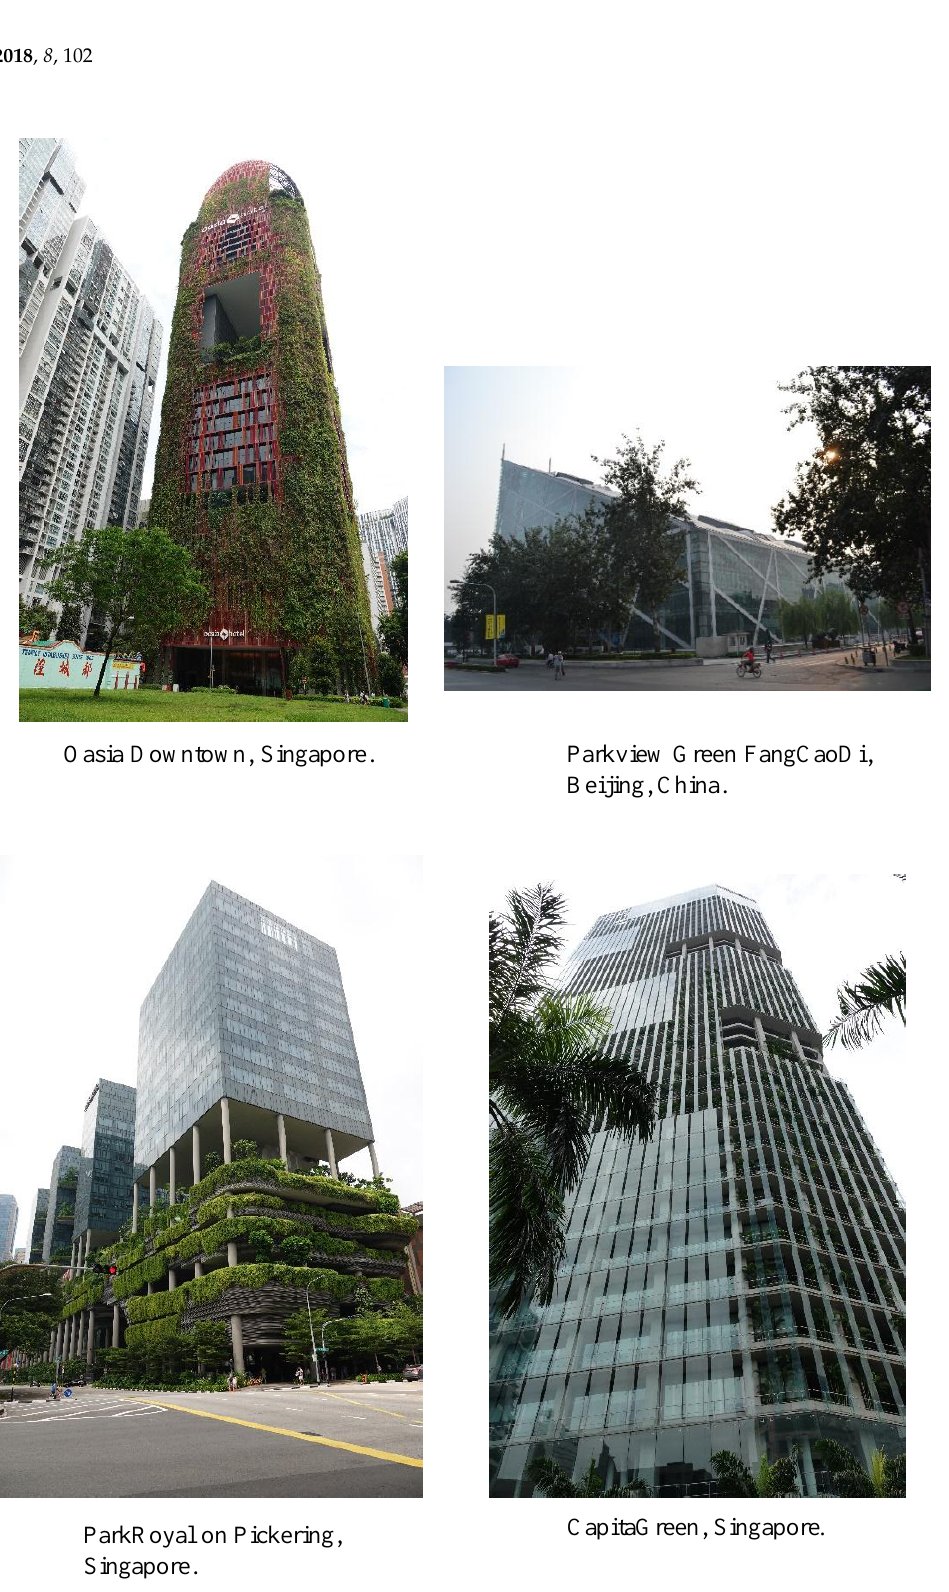
Figure 1. Cont. Figure 1. Southeast Asia and the Far